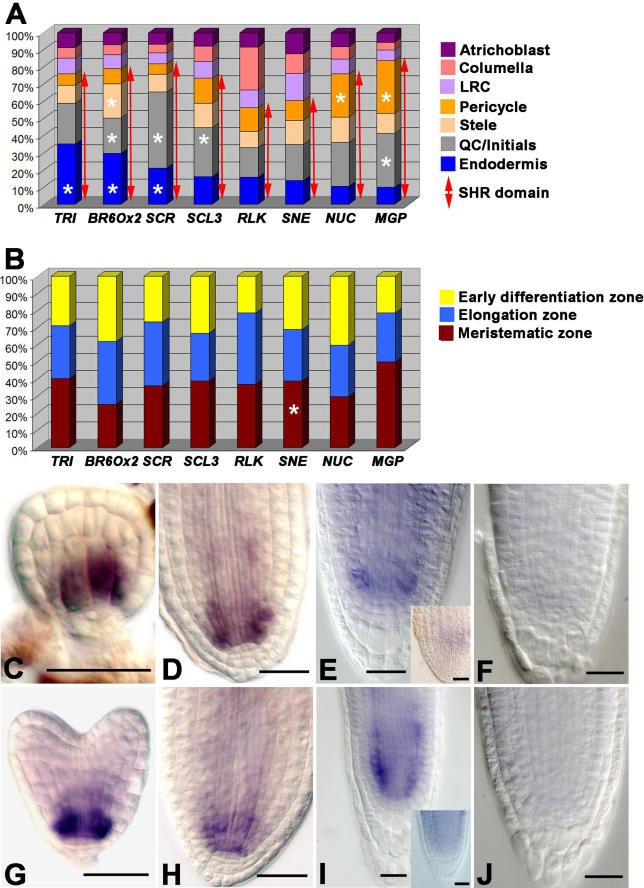
The SHR Direct Targets Are Regulated In Planta by SHR and Are Significantly Enriched in the SHR Domain(A and B) Expression of SHR direct targets in the root using the digital in situ data. (A) Relative expression of the SHR direct targets in the radial zones. (B) Relative expression of the SHR direct targets in the longitudinal root zones. A statistical analysis of the digital in situ data was performed to determine if the SHR direct targets are enriched in tissues in which the SHR protein is present (SHR domain, designated with a red arrow): the quiescent center and initials (QC/initials), endodermis, pericycle, and stele. A similar analysis was performed to determine significant enrichment in a specific longitudinal zone. The asterisk (*) marks the zone in which enrichment was found statistically significant in those analyses. See
Materials and Methods for a description of the statistical analysis.
(C–F) Whole-mount in situ hybridization of
MGP in wild-type and
shr-2 embryonic and postembryonic tissues. (C) Wild-type globular embryo. (D) Root of wild-type torpedo embryo. (E) A 2-d-old wild-type root. Inset in (E): A 2-d-old wild-type root hybridized with
MGP sense probe. (F) A 2-d-old
shr-2 root.
(G–J) Whole-mount in situ hybridization of
NUC in wild-type and
shr-2 embryonic and postembryonic tissues. (G) Wild-type transition embryo. (H) Root of wild-type torpedo embryo. (I) A 2-d-old wild-type root. Inset in (I): A 2-d-old wild-type root hybridized with
MGP sense probe. (J) A 2-d-old
shr-2 root.